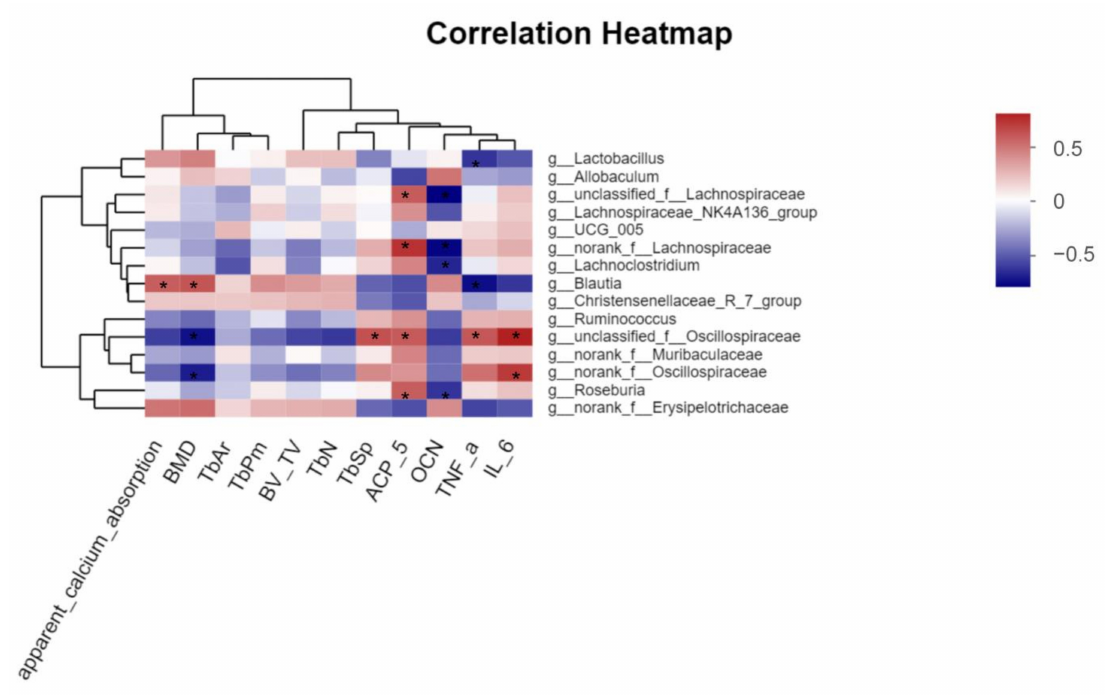
Figure 10. Correlation analysis between other parameters and the relative abundance of inferred key bacteria. The Majorbio cloud platform’s web tool (https://cloud.majorbio.com/page/tools/, accessed on 20 November 2022) was utilized to perform correlation analysis, and R values are indicated by colors with different depths (* |R| ≥